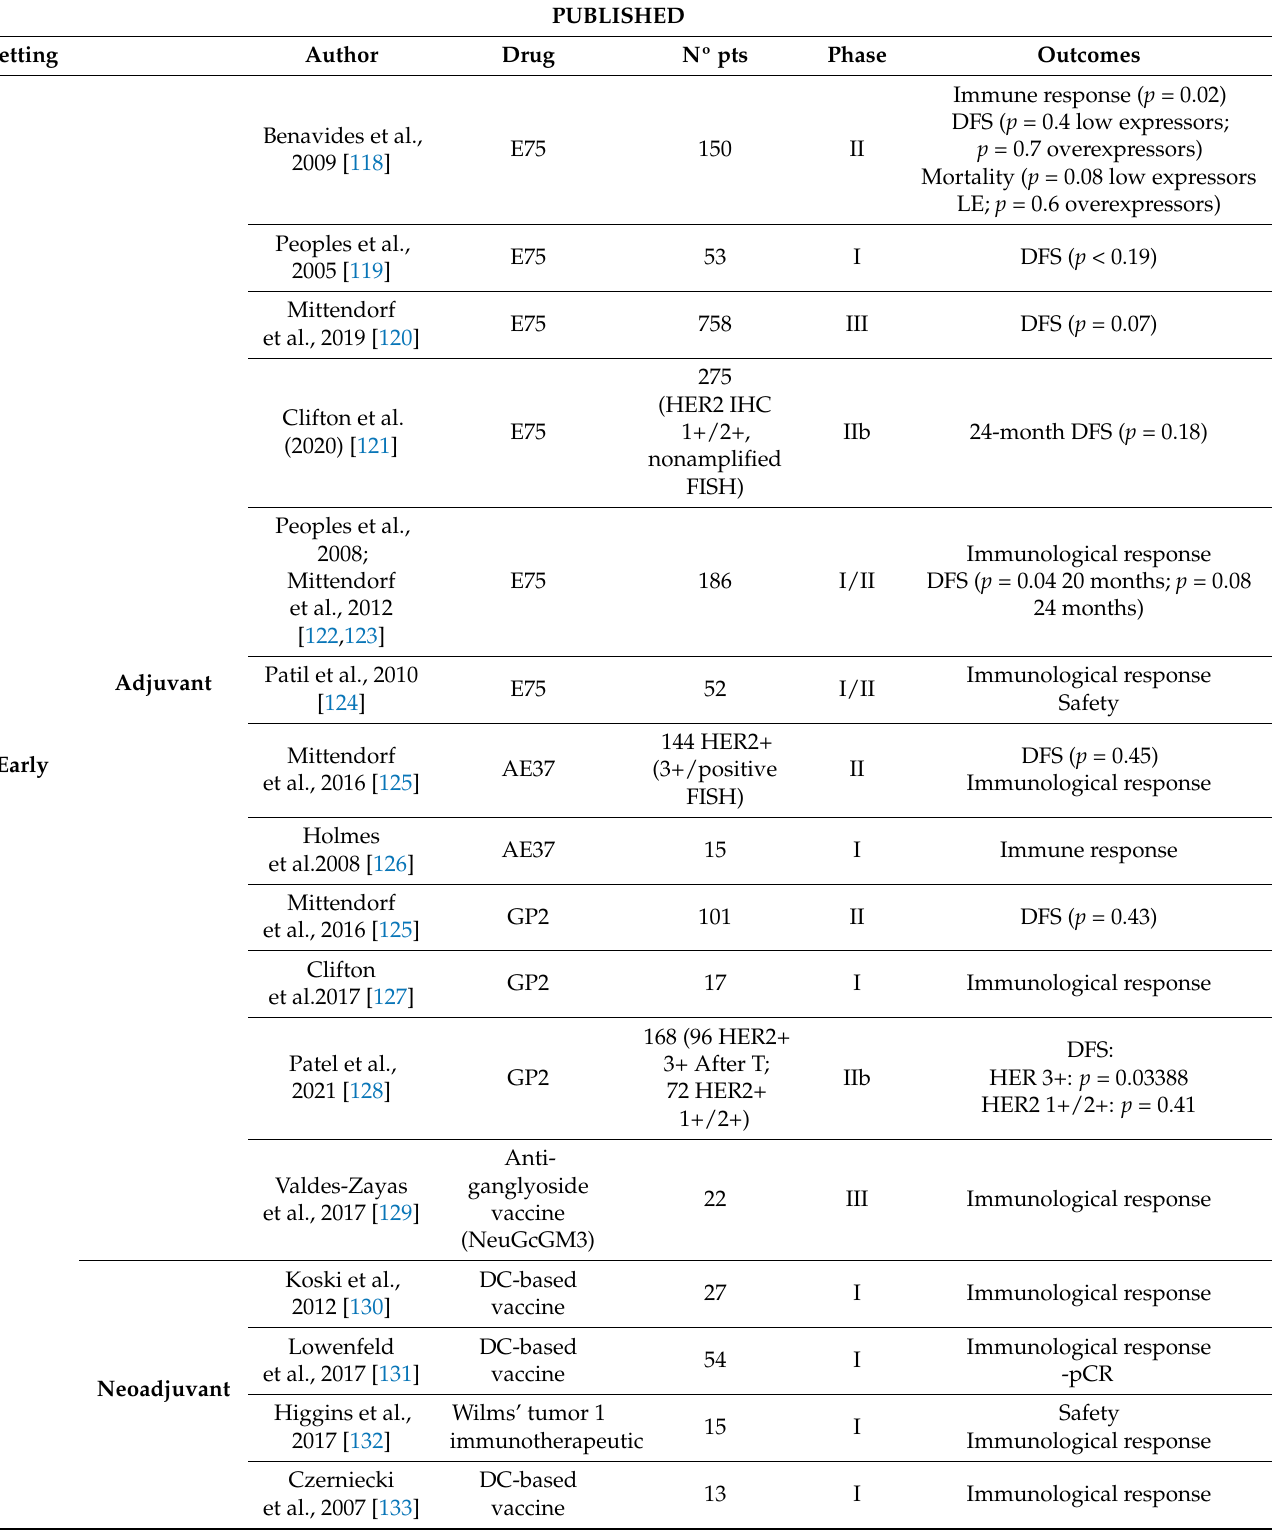
Table 3. Published clinical trials with HER2+ breast cancer patients treated with anti-HER2